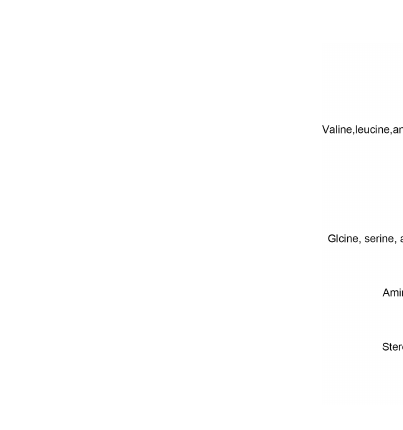
FIGURE 5 | KEGG pathway enrichment analysis of differential